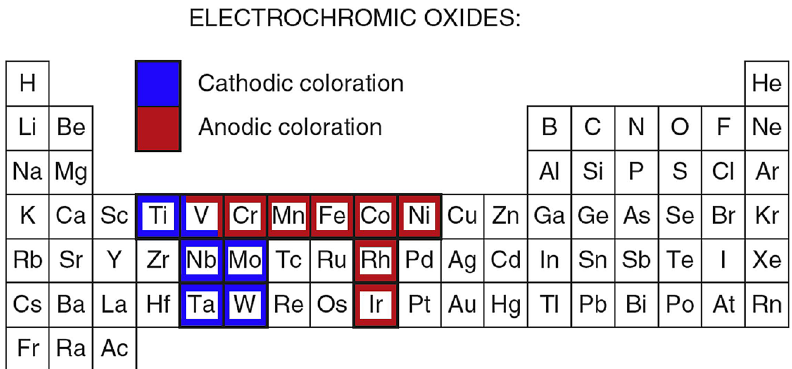
Figure 1: Electrochromic transition metal oxides showing both cathodic and anodic coloration. Reproduced with permission from Ref. [35]. Copyright 2017, Elsevier